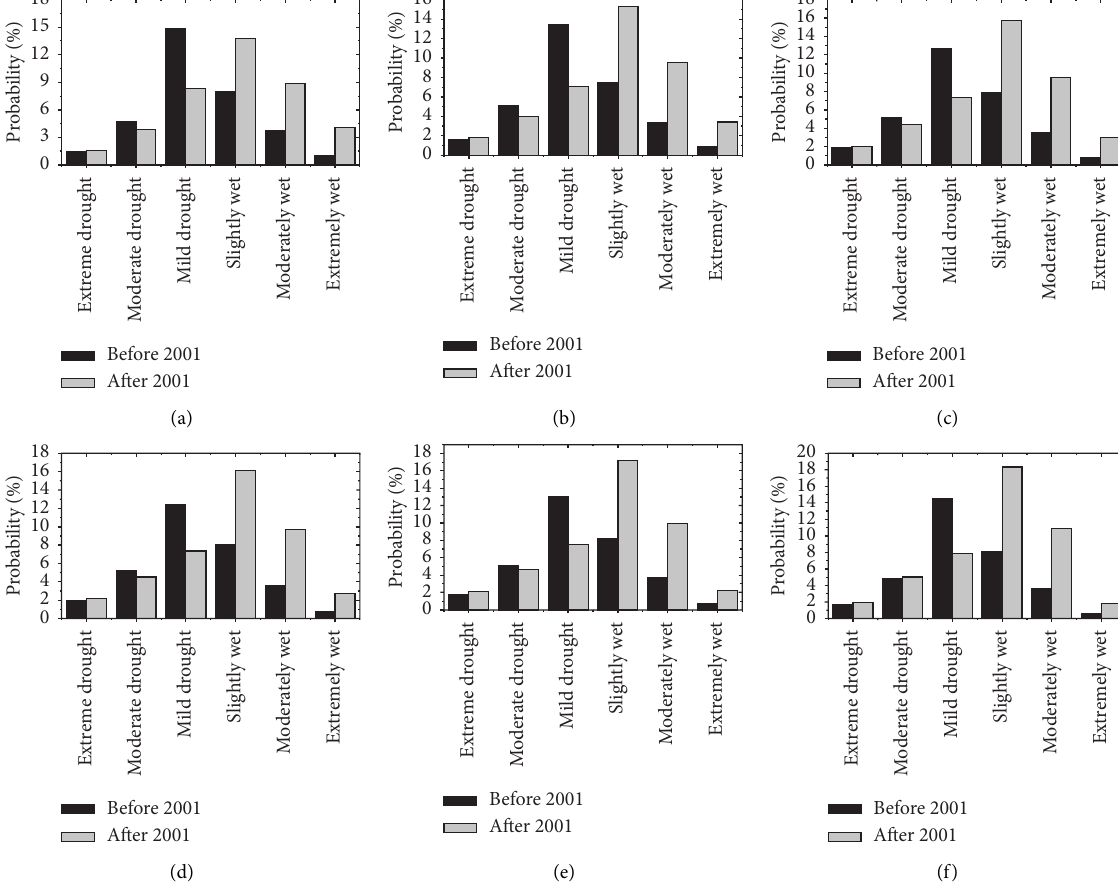
Figure 4: Changes of drought and wetness probability before and after 2001. (a) SPEI-1. (b) SPEI-3. (c) SPEI-6. (d) SPEI-9. (e) SPEI-12. (f) SPEI-24.